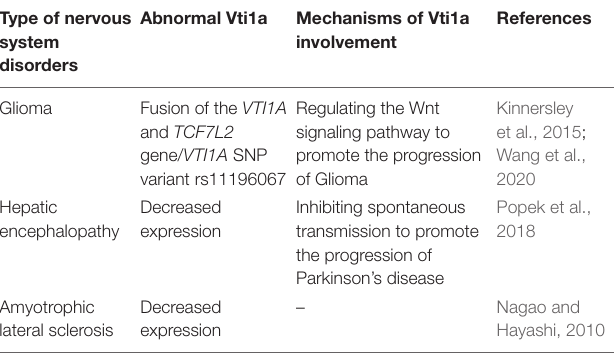
TABLE 1 | The role of Vti1a in neurological disorders.